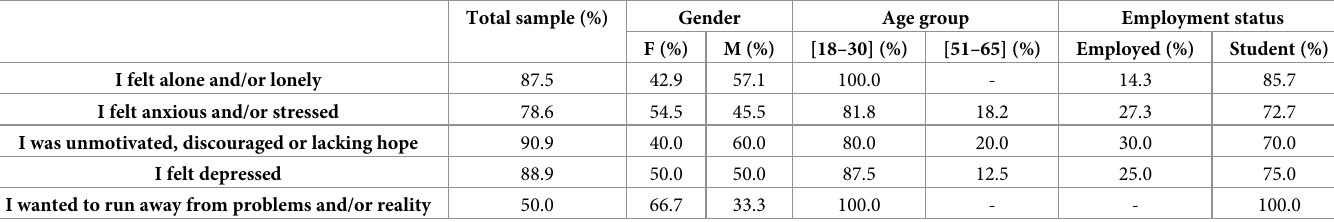
Table 2. Reasons that promoted the increase of illegal substances consumption during the COVID-19